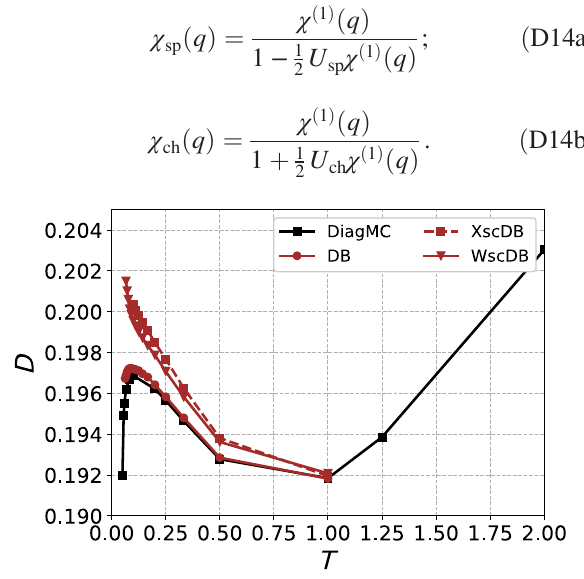
FIG. 37. Results from alternative DB schemes — single-shot (DB), self-consistent (XscDB), and W-self-consistent (WscDB) — for the double occupancy compared to